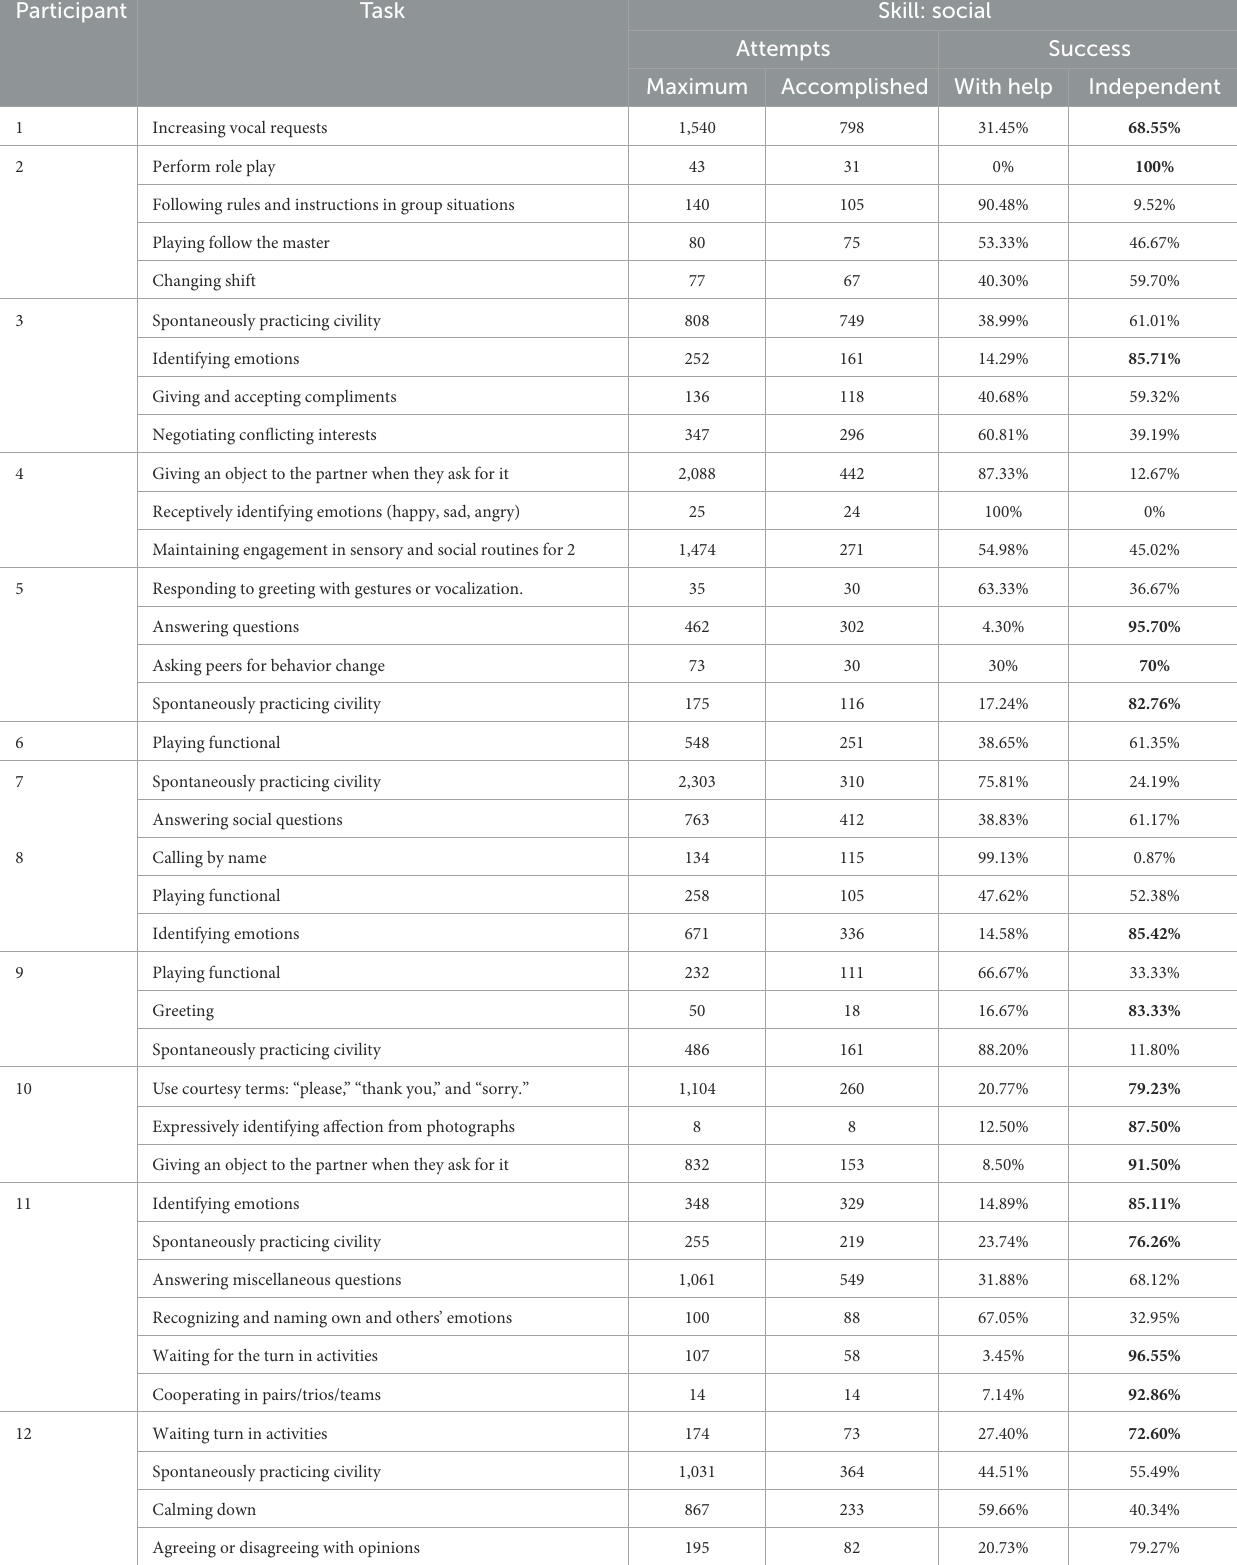
TABLE 5 Participants’ task training results for social